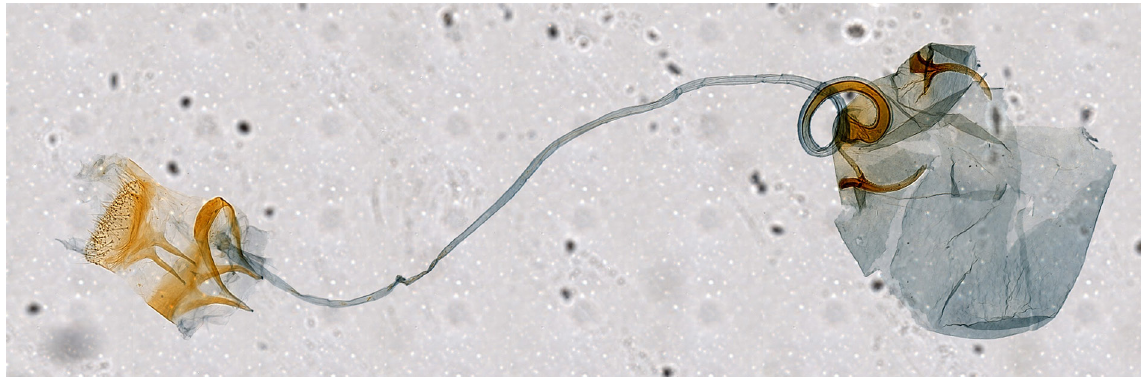
Fig. 2.15. Caloptilia galacotra , reproductive organs. Picture composed of several stitched tiles of stacked pictures at a magnification of 20×.